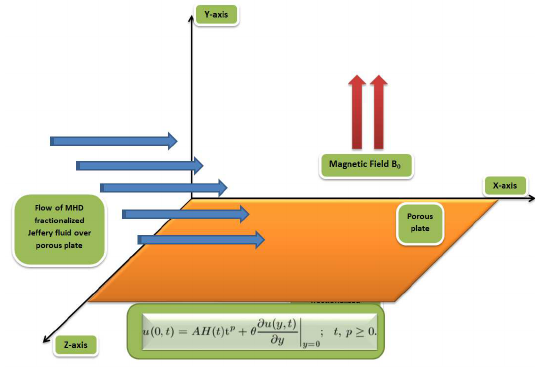
Figure 1: Flow of MHD fractionalized Jeffrey fluid over an accelerated slipping porous